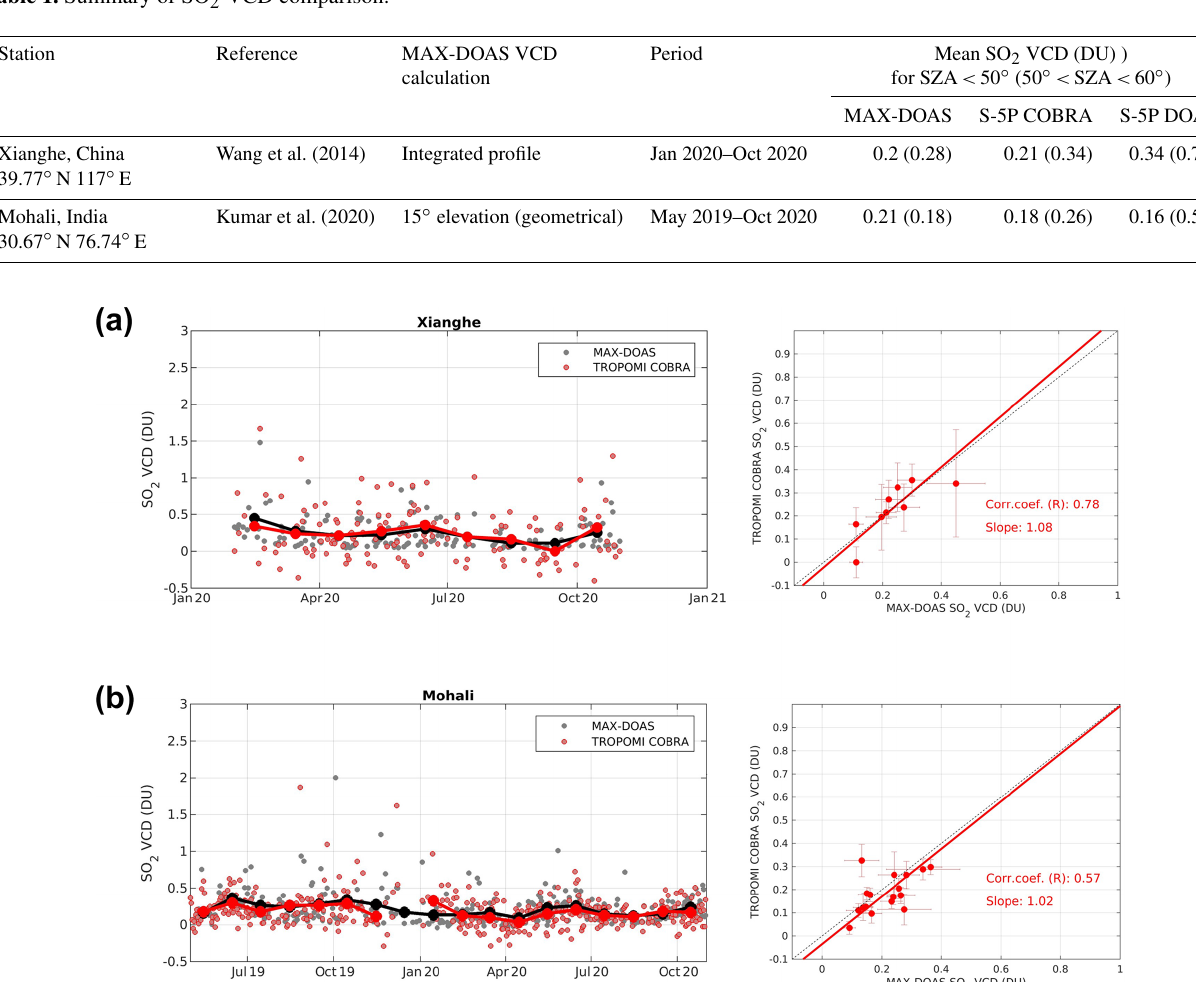
Figure 5. The left panels show comparison of monthly mean SO 2 columns from MAX-DOAS and TROPOMI COBRA for (a) Xianghe and (b) Mohali. The grey and pale red dots correspond to the individual days. The right panels show scatter plots of monthly mean SO 2 columns of TROPOMI COBRA vs. MAX-DOAS observations. Error bars are the standard errors on the monthly average SO 2 columns. The correlation coefficient and slope of the regression line are given as an inset for each